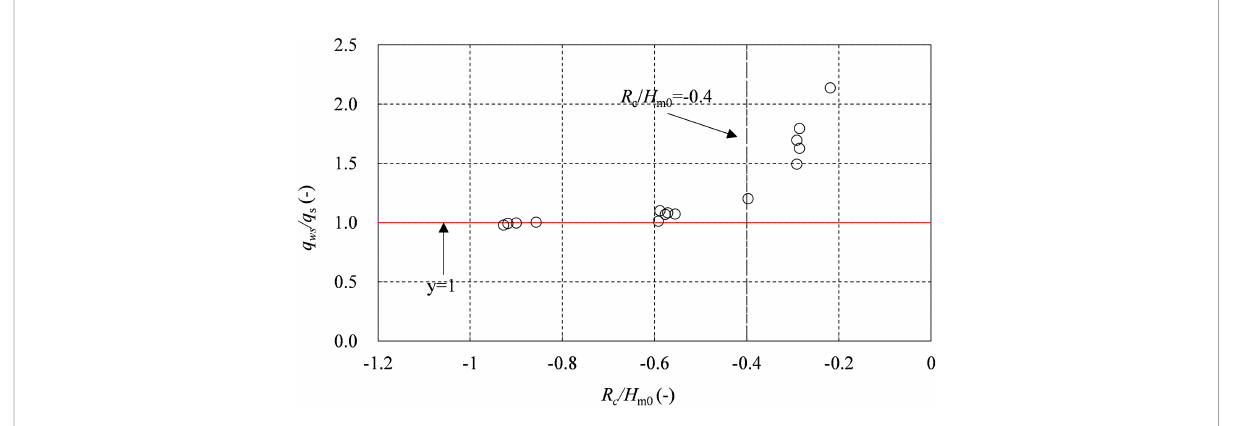
FIGURE 6 q q versus the relative negative ws / s